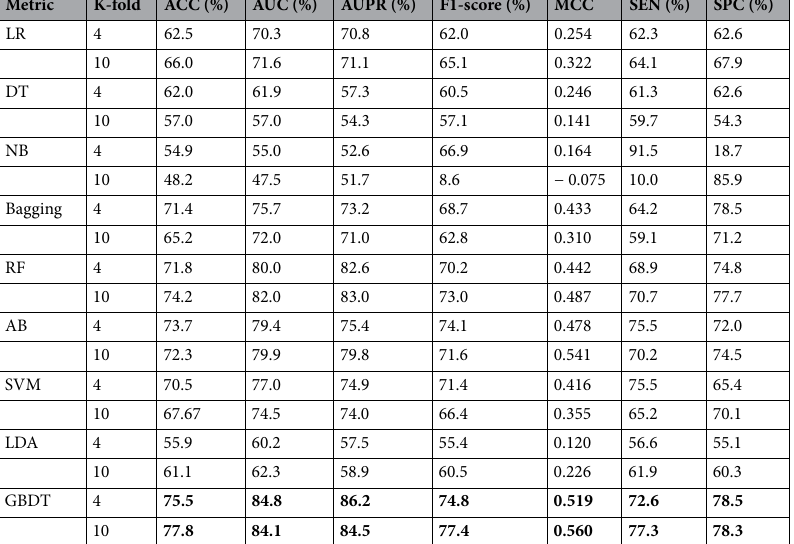
Table 9. The performance evaluation of the proposed system based on the GBDT compared with state-of-the- art classifiers using 4-fold and 10-fold cross-validation techniques based on the lncRNA dataset. Significant values are in